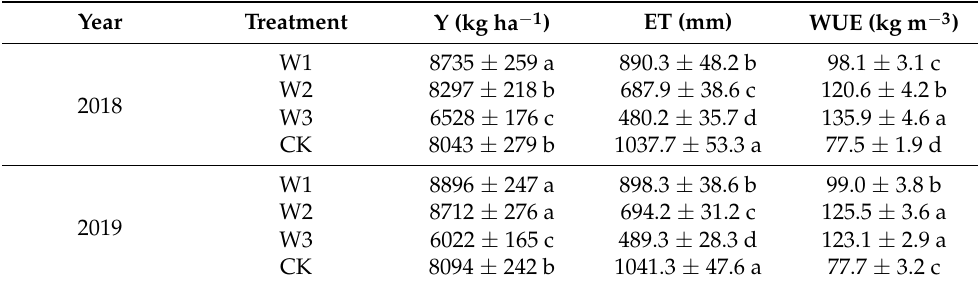
Table 5. Jujube fruit yield (Y), evapotranspiration (ET), and water use efficiency (WUE) in different irrigation treatments in 2018 and